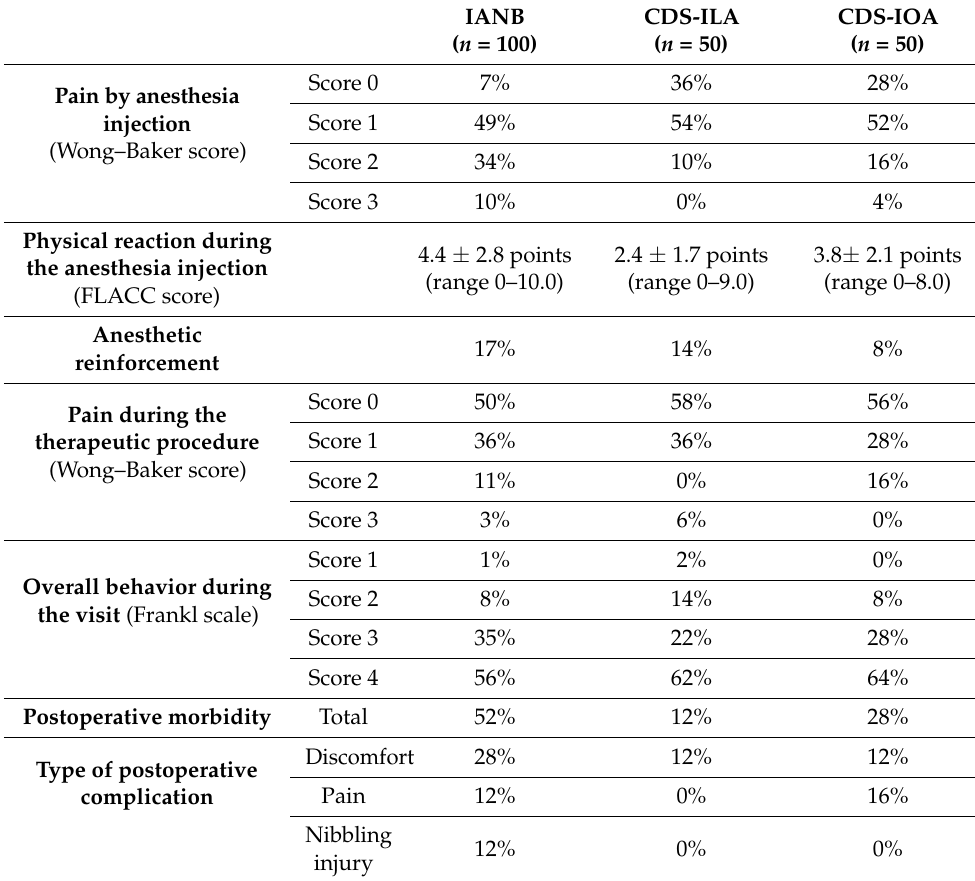
Table 1. Percentage distribution of the scores corresponding to the outcome variables (first column), obtained from the study group according to the applied anesthesia